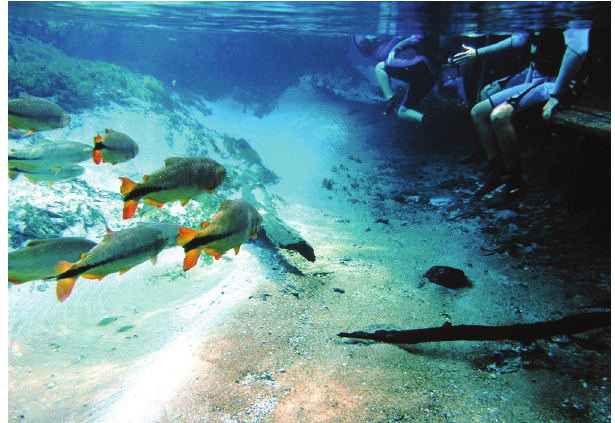
Fig. 3. Image illustrating under water visibility at the begin- ning of the snorkeling excursion and the presence of tourists (Lima,